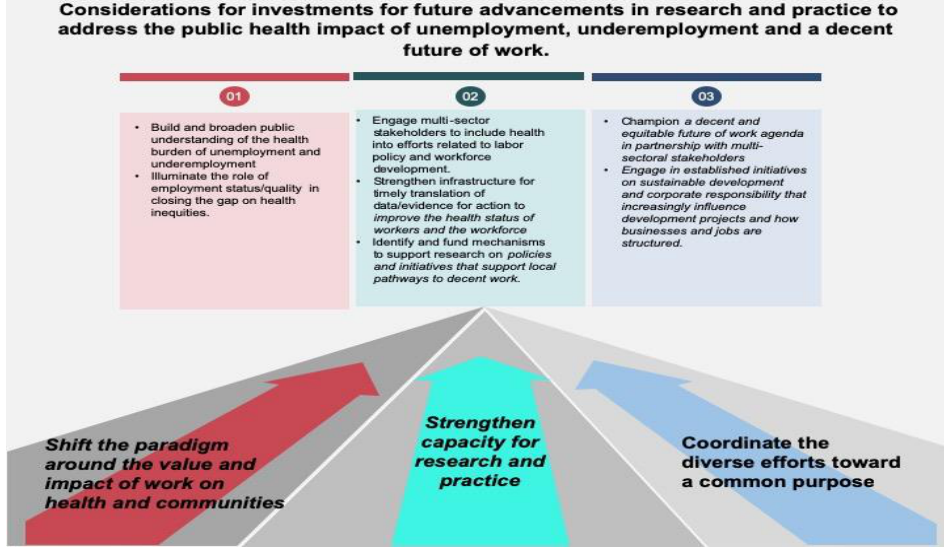
Figure 2. Considerations for a common framework to address the public health impact of underemployment and unemployment, and promote a decent future of work.